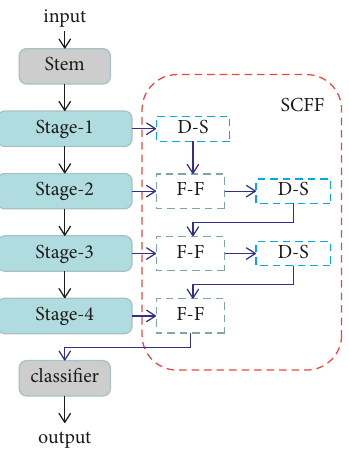
Figure 2: The structure of